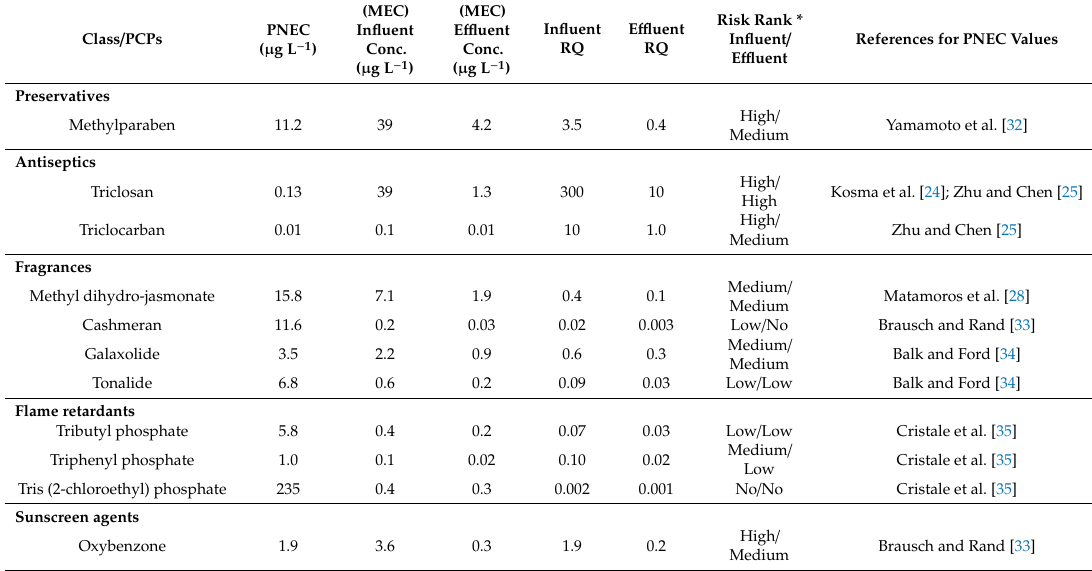
Table 2. Risk assessment of 11 selected PCPs based on influent and e ffl uent concentration in CWs. Class /